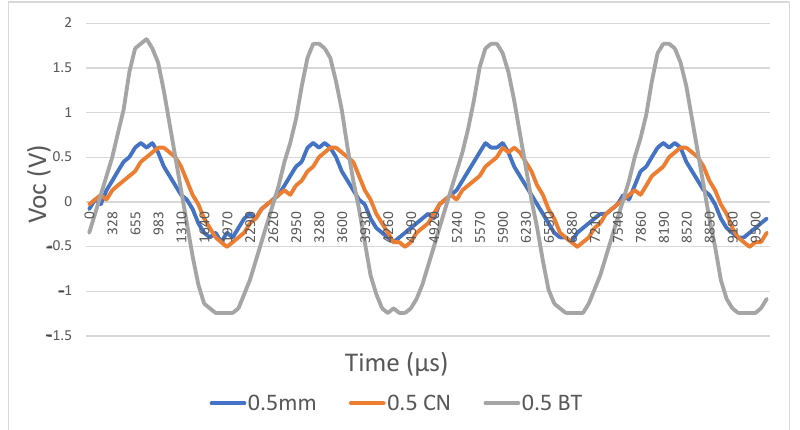
Figure 13. Open circuit voltage as a function of different maximum gap distances.